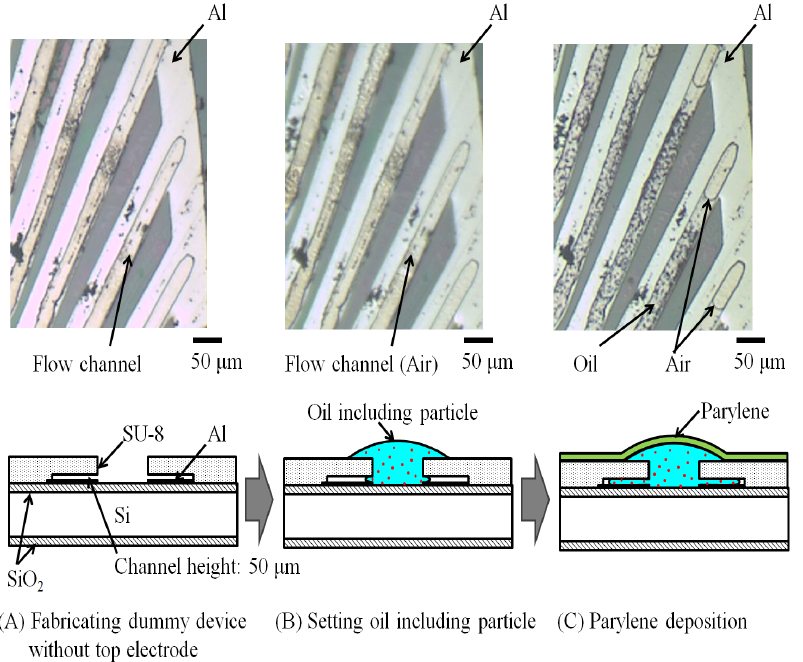
Figure 11. Oil position at packaging process